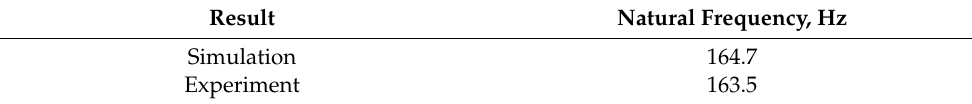
Figure 4. Finite element model of the wing. Figure 3. Planform ( left ) and cross section at root ( right ) of the wing model. Table 3. Natural frequencies of the wing obtained from the test and simulation.